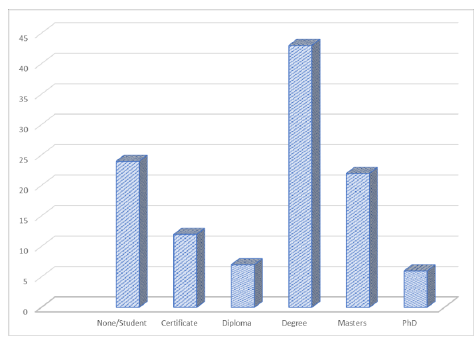
Figure 10: Professional/Academic backgrounds of